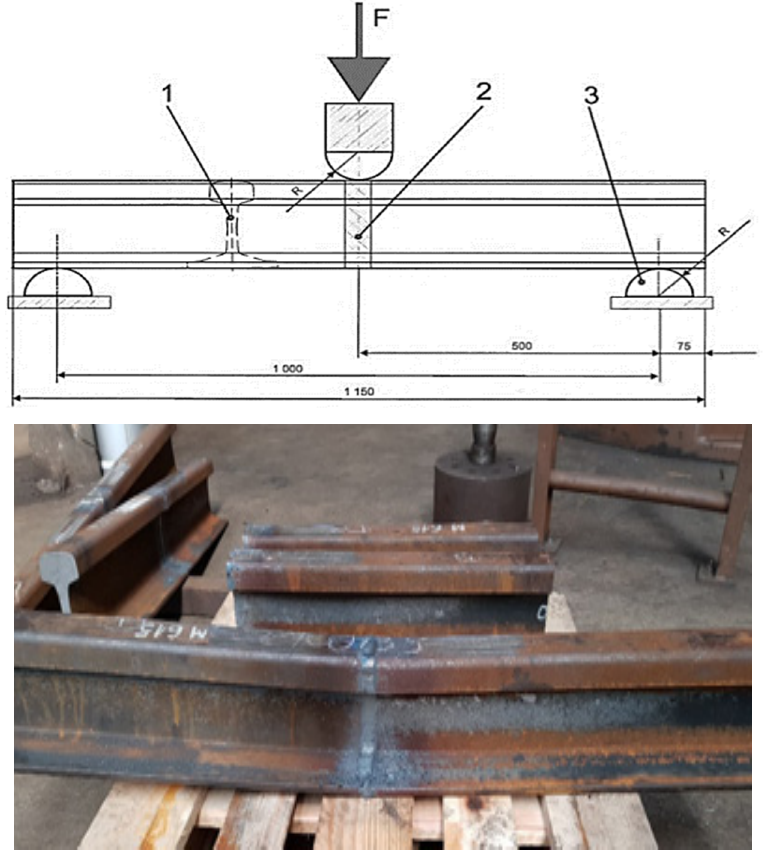
Figure 16. The bending scheme and the appearance of the sample after the test. Source: own.